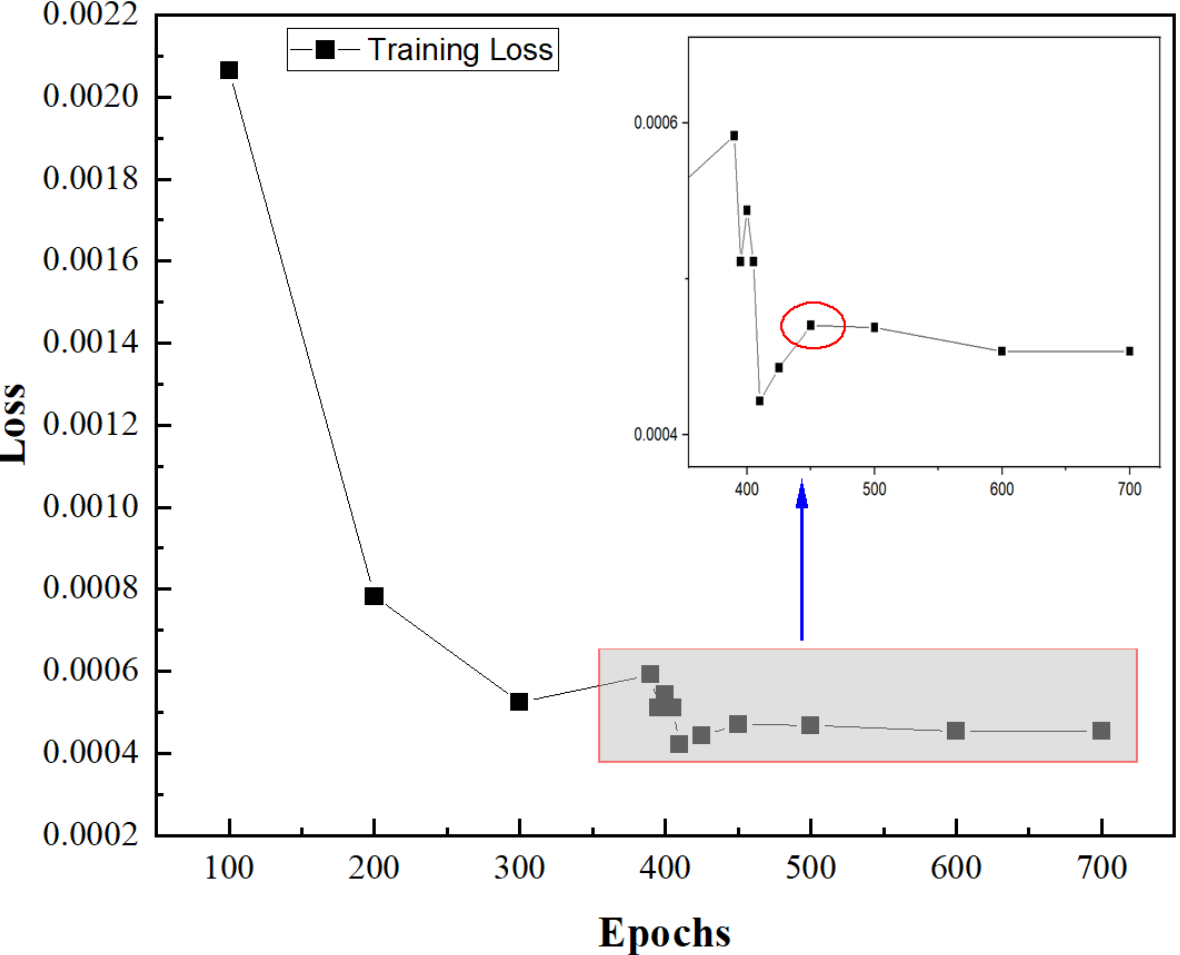
Figure 2. Training set loss value at different training times.